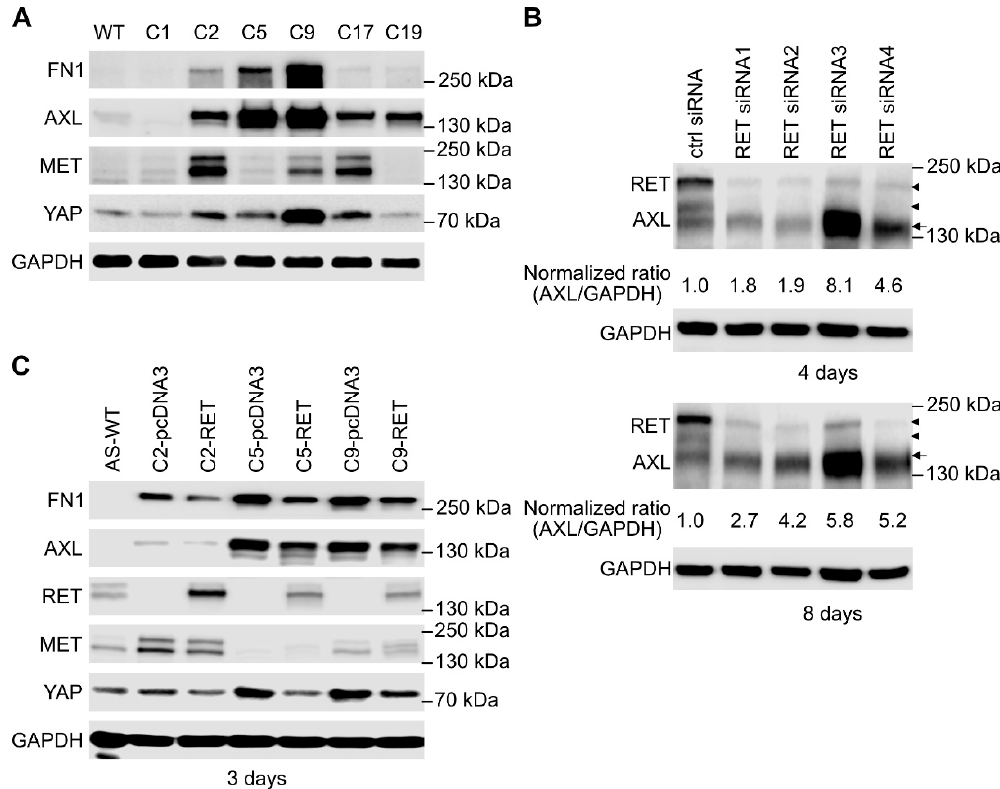
Cancers 2021 , 13 , x FOR PEER